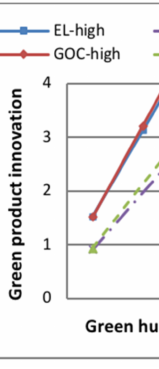
Figure 3. The moderating effect between GHC and GI1.